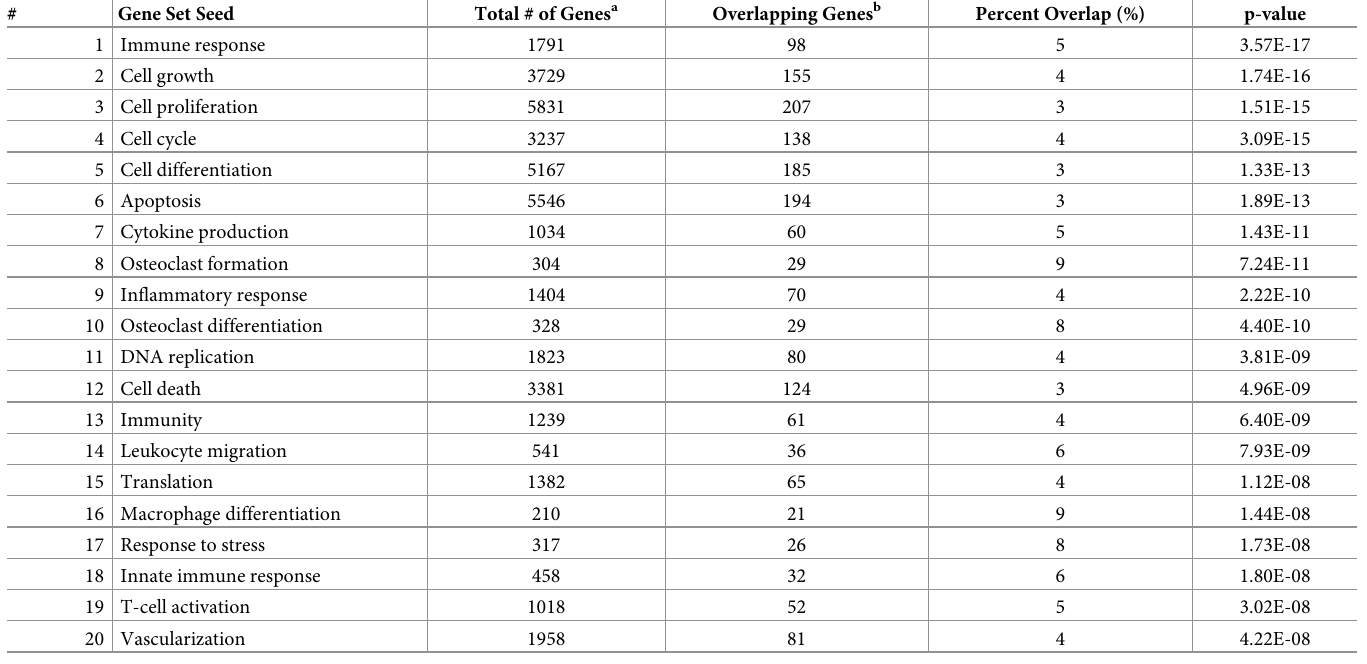
Table 4. Cellular process pathway analysis of genes differentially expressed in red tide and control Florida manatees. The number of overlapping genes between the experimental groups, percentage overlap, and significance of overlap (p-value) are